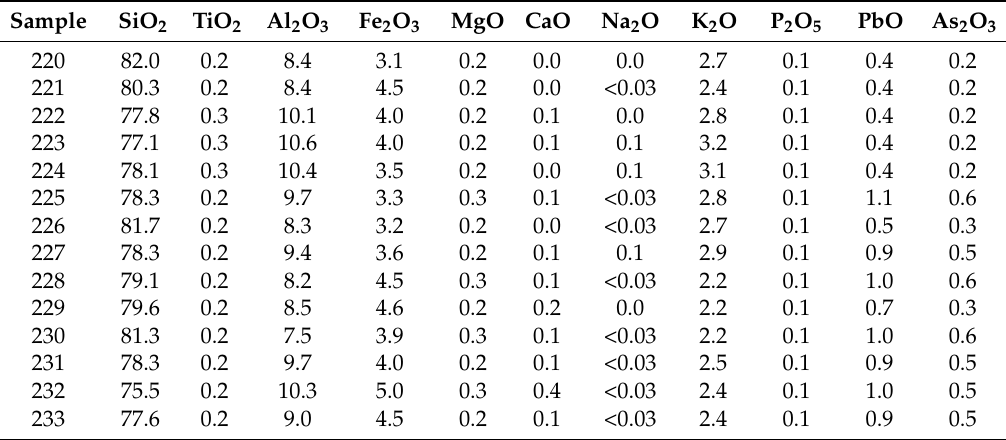
Figure 5. Box and whisker plot showing heap leach trace element chemistry ( n = 14) with select environmentally significant elements shown. (NB. The box covers the interquartile range, the line is the median and the circle the mean. The whiskers are drawn at the threshold to identify near and far outliers based on the Tukey statistic). Table 2. Whole-rock chemical analyses (wt %; LOI values not shown).